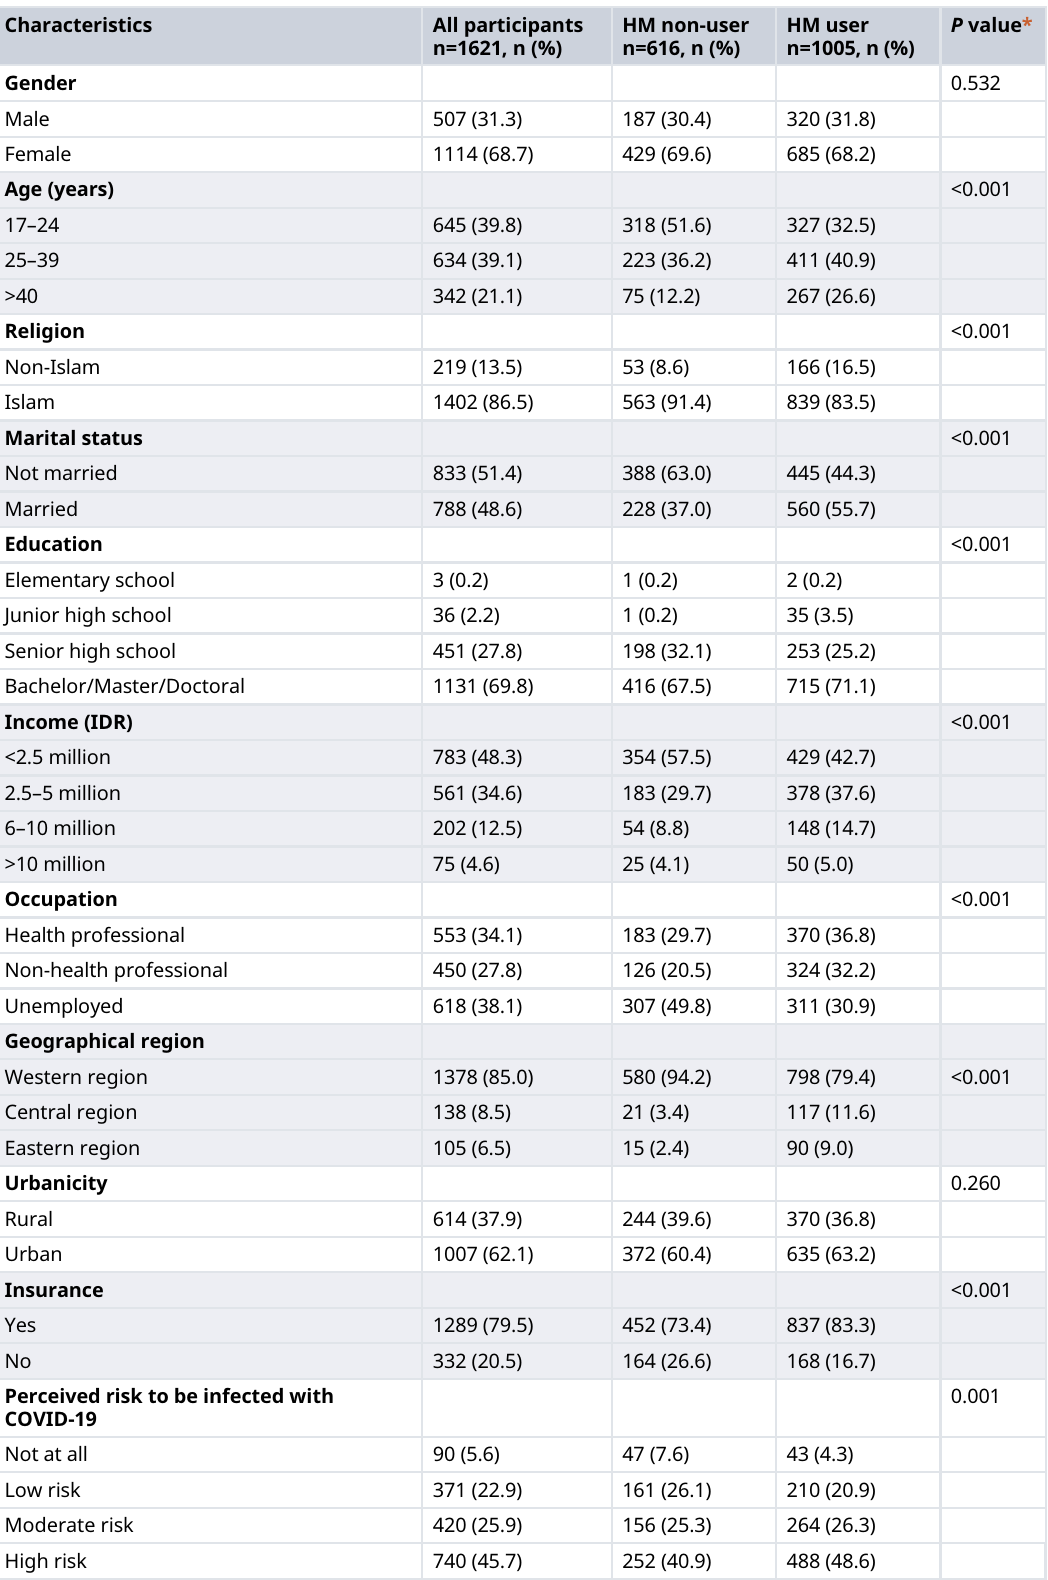
Table 1. Relationships of distributions of demographic and determinant factors with use herbal medicine (HM) and HM non-user during COVID-19 pandemic (n=1621).